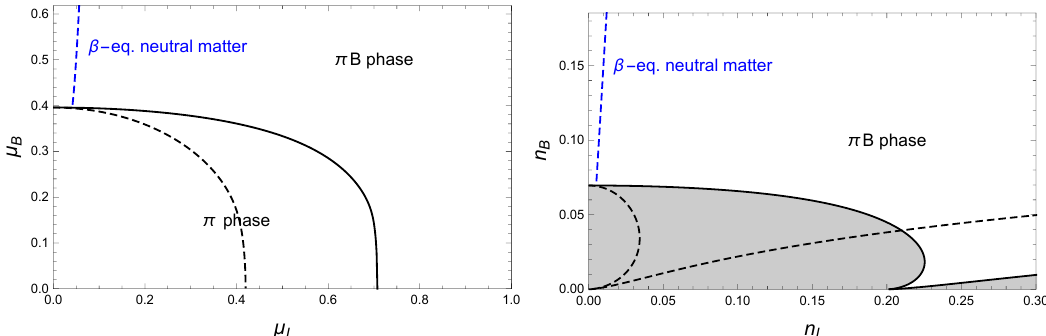
Figure 5: Phase diagram in the µ - µ plane (left) and in the n - n plane (right) for λ = 15. I B I B In both diagrams (black) solid lines are the actual phase transition lines, while the dashed lines correspond to the situation where pions are ignored, i.e., they show the phase transition from the vacuum to the B phase. The (blue) almost vertical dashed curves indicate beta- equilibrated, charge neutral matter, including leptons in the B phase. No stable homogeneous phase exists in the shaded areas in the right